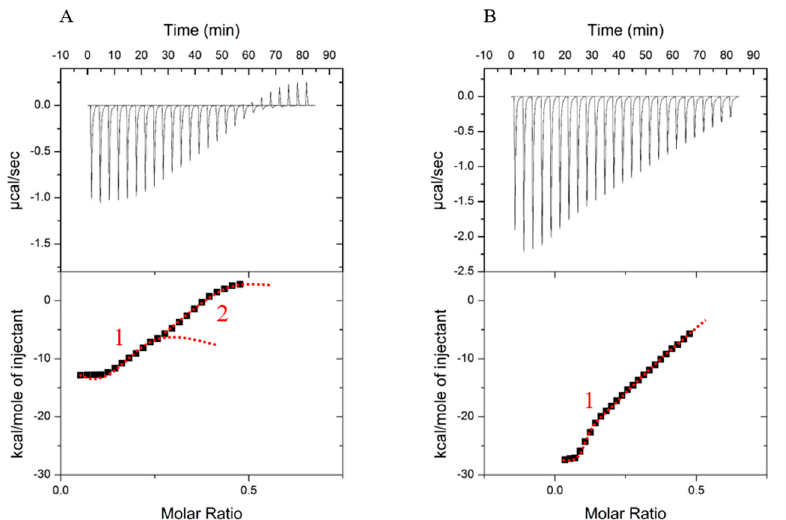
Figure 3. Heat flow thermogram as a function of the time ( upper panel ) obtained during the titration of β LG (0.1 mM) by LF (0.25 mM) in 10 mM MES buffer pH 5.5 at 25 ◦ C ( A ) and 35 ◦ C ( B ). Bottom panel: corresponding graphical representation of the integrated data of enthalpy versus the molar ratio of LF: β LG with no added salt. The red line is just to guide the eyes to distinguish when applicable the two inflection points. Inflection points are indicated by numbers 1 and 2.